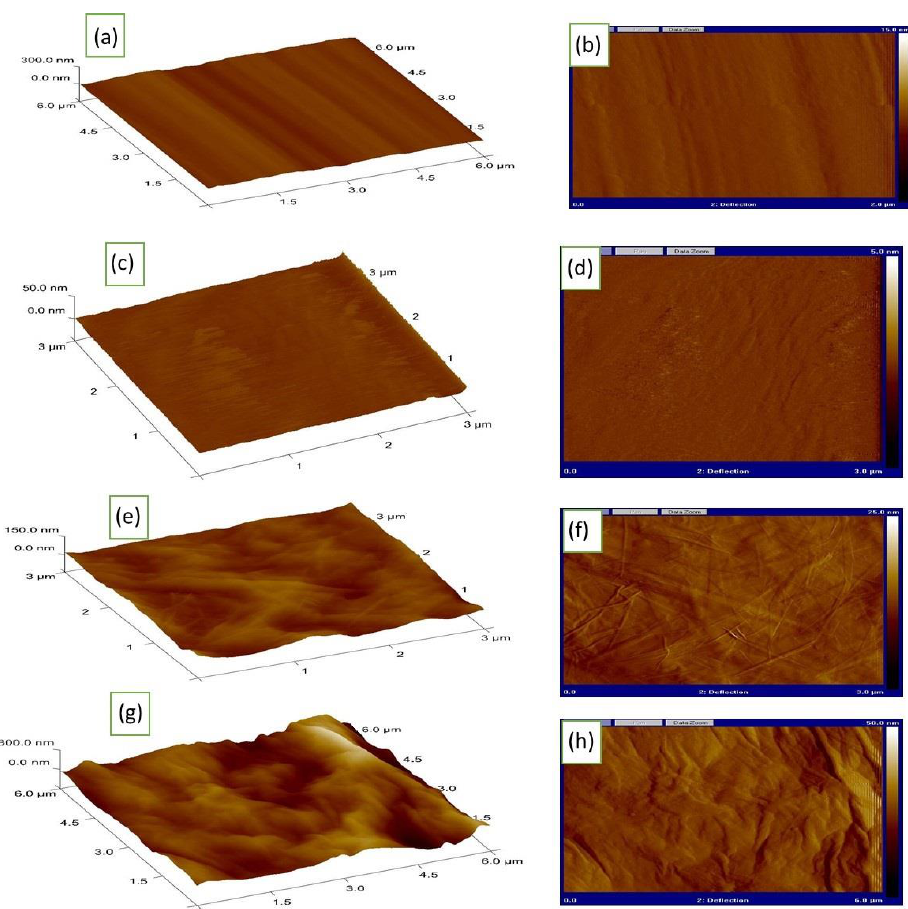
Figure 4. AFM graphs for ( a , b ) polished Ni bare, ( c , d ) β - Ni(OH) 2 , ( e , f ) Ni/β - Ni(OH) 2 /4L GO before exposure, and ( g , h ) Ni/β - Ni(OH) 2 /4L GO after exposure. Table 1. Surface roughness of the examined surfaces determined from AFM.